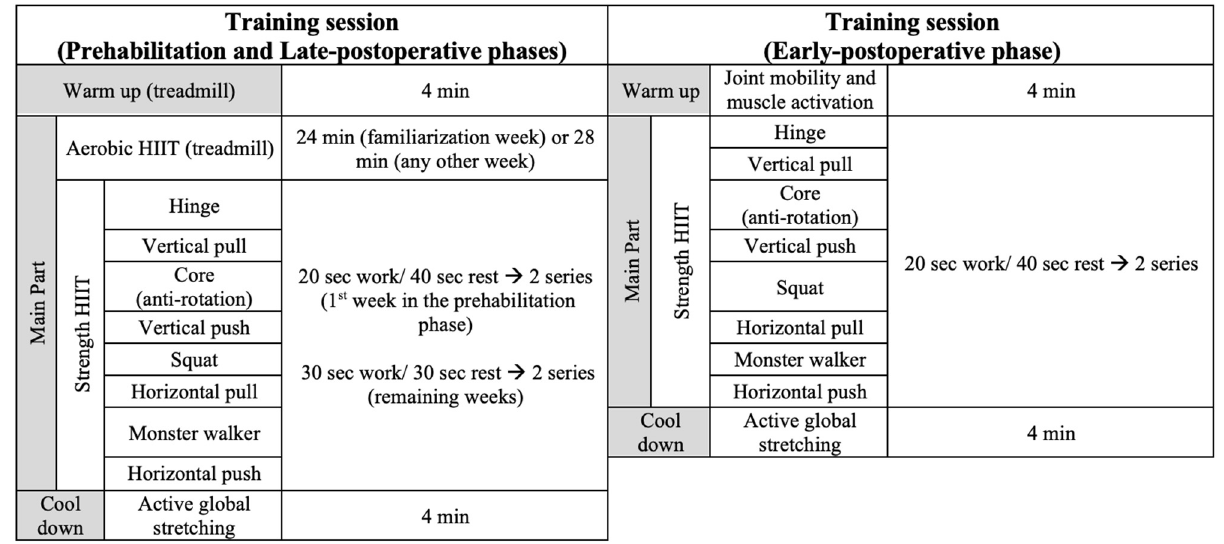
Figure 3. Structure of the implemented concurrent training session within the prehabilitation and postoperative phase. Abbreviations: HIIT; High Intensity Interval Training. postoperative phase. Abbreviations: HIIT; High Intensity Interval